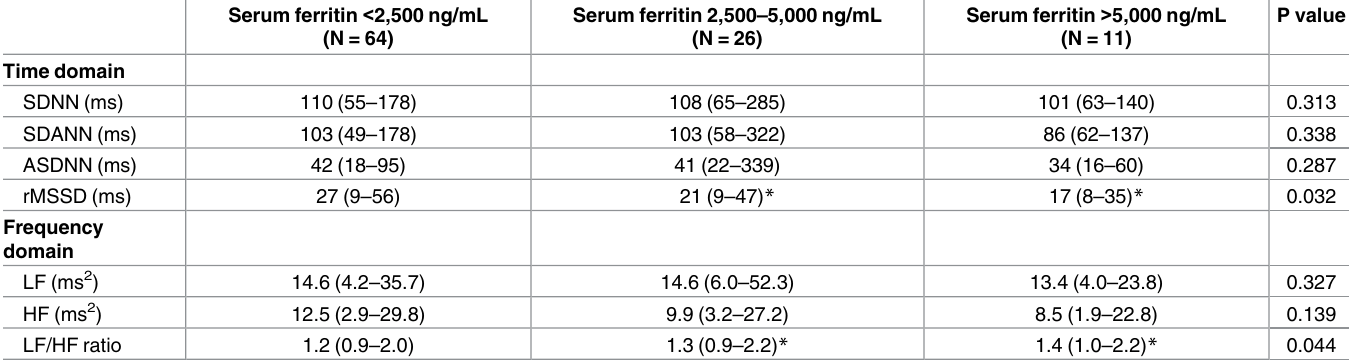
Correlations between HRV and mean hemoglobin during the last 12 months, mean serum fer- ritin during the last 12 months, mean serum ferritin during the past 5 years, maximum serum ferritin during the past 5 years, NTBI and cardiac T2 (cid:3) values are summarized in Table 3. Using Table 2. Heart rate variability parameters according to the mean serum ferritin during the past 5